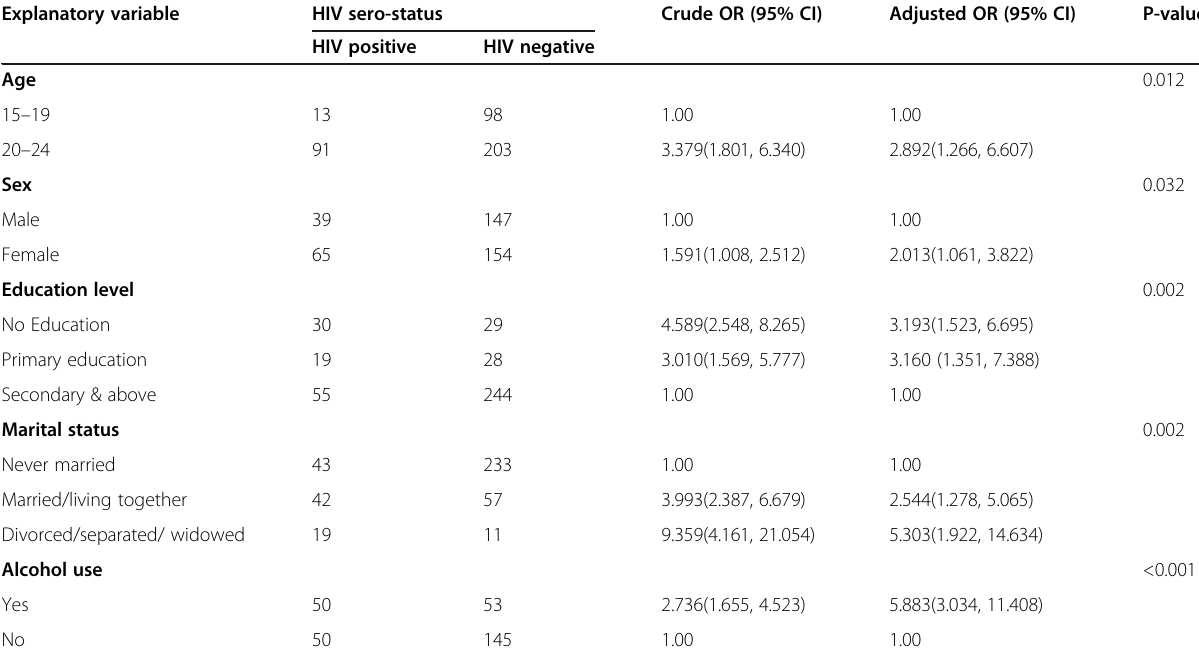
Table 4 Factors associated with HIV infection among youths (Crude & adjusted OR) in Gamo-Gofa, South West Ethiopia,